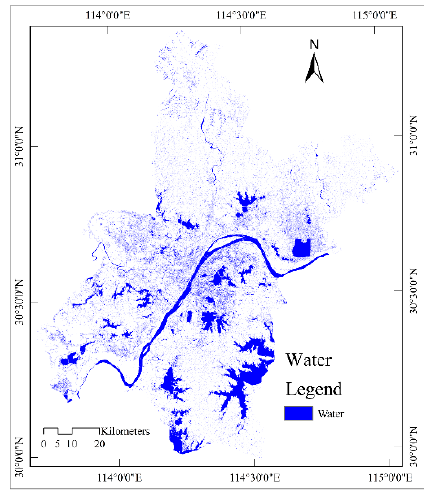
Figure 4. The extraction result of water.